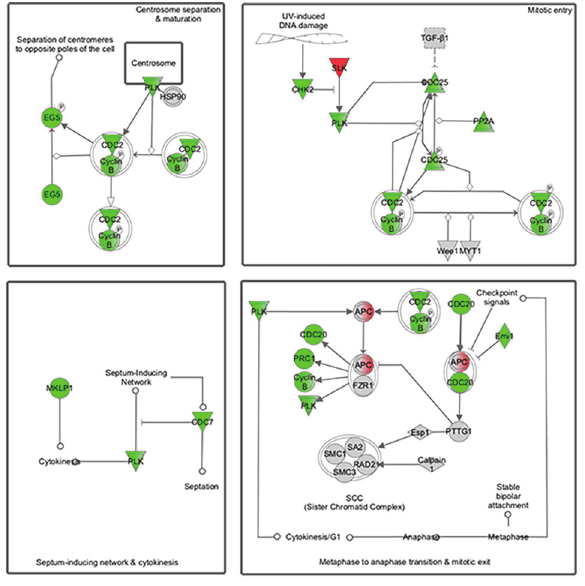
Fig 5. Differential mRNA expression in quadriceps muscle from Cfl2 deficient mice compared to wild- type littermates for cell cycle. Color representations are the same as described in Fig 3.